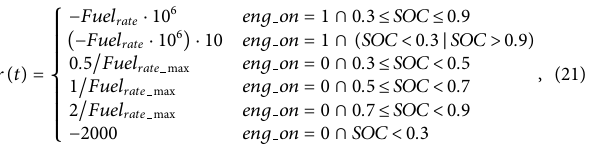
where eng on (cid:1) 1 indicates that the engine is turned on, eng on (cid:1) 0 indicates that the engine is turned off. Fuel rate max indicates to the maximum value of engine fuel consumption MAP as shown in Figure 3. A special explanation has to be made here: the engine on – off mode is simply an on – off threshold, that is, when the engine power is greater than a certain threshold, the engine is turned on, and when it is less than this threshold value, the engine is turned